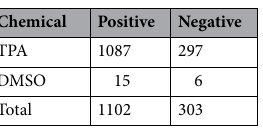
Table 1. Number of images of suspected